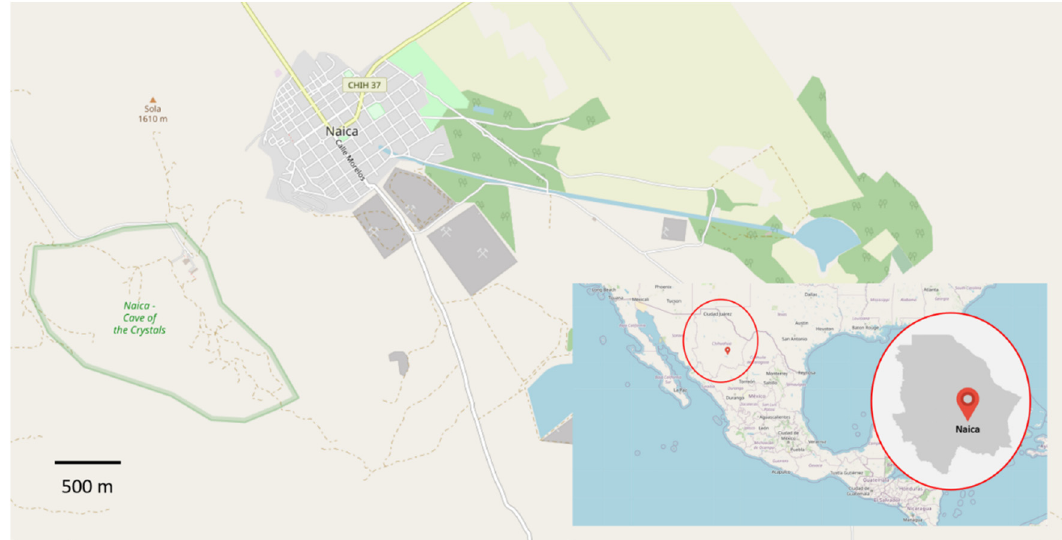
Figure 1. Naica, Chihuahua, Mexico. On the left (in green), the size of the mine can be compared with the town itself. Adapted with an Open Data Commons Open Database License (ODbL). © OpenStreetMap contributors.